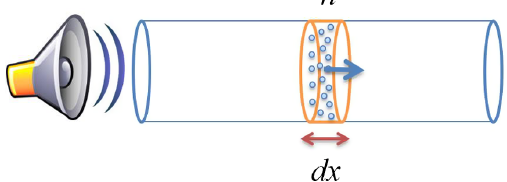
FIG. 3. The element of length dx is pushed forward. The arrow shows the most probable direction of the n molecules ’